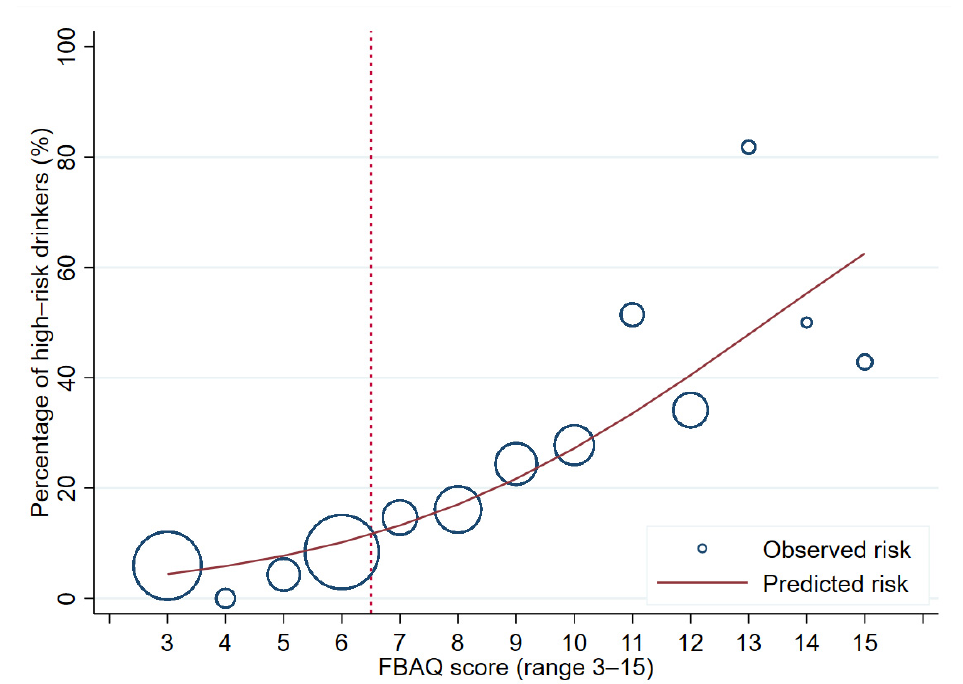
Figure 2. Calibration plot visualizing the agreement between the functional-belief-based alcohol-use questionnaire (FBAQ) score and the probability of being a high-risk drinker. Predicted-risk curve (red line) and observed risk (hollow blue circle) are shown, when the 12-month AUDIT was used as reference standard.